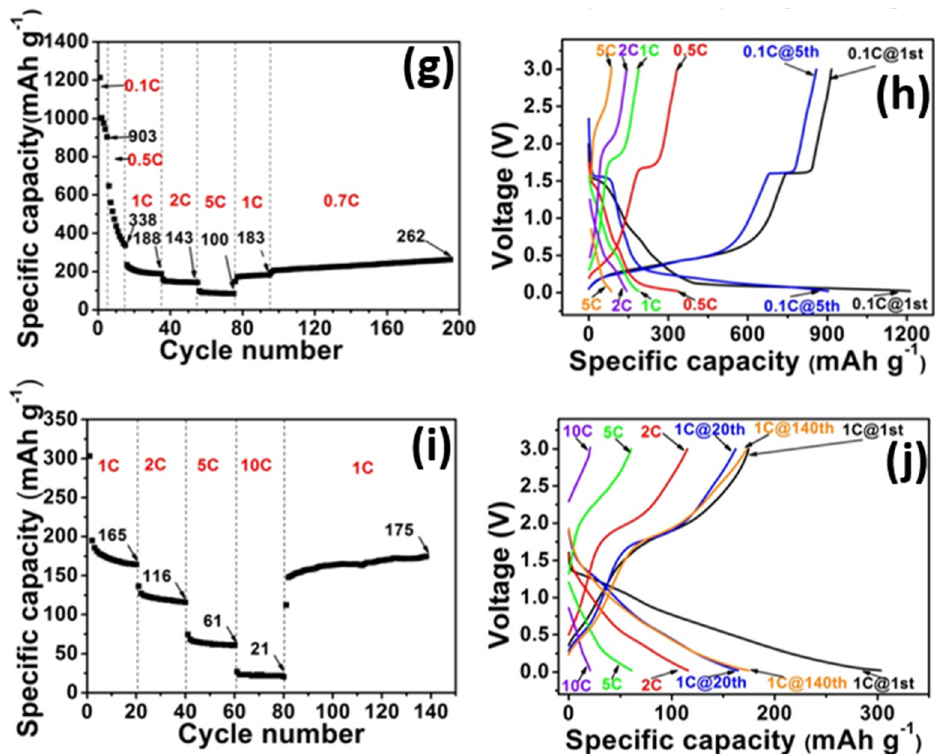
Figure 3. The rate performance and corresponding charge-discharge curves for electrodes based on pure-Si ( a , b ), pure-LTO ( c , d ), 35LTO35Si ( e , f ), 50LTO20Si ( g , h ) and 65LTO5Si ( i , j ), respectively.